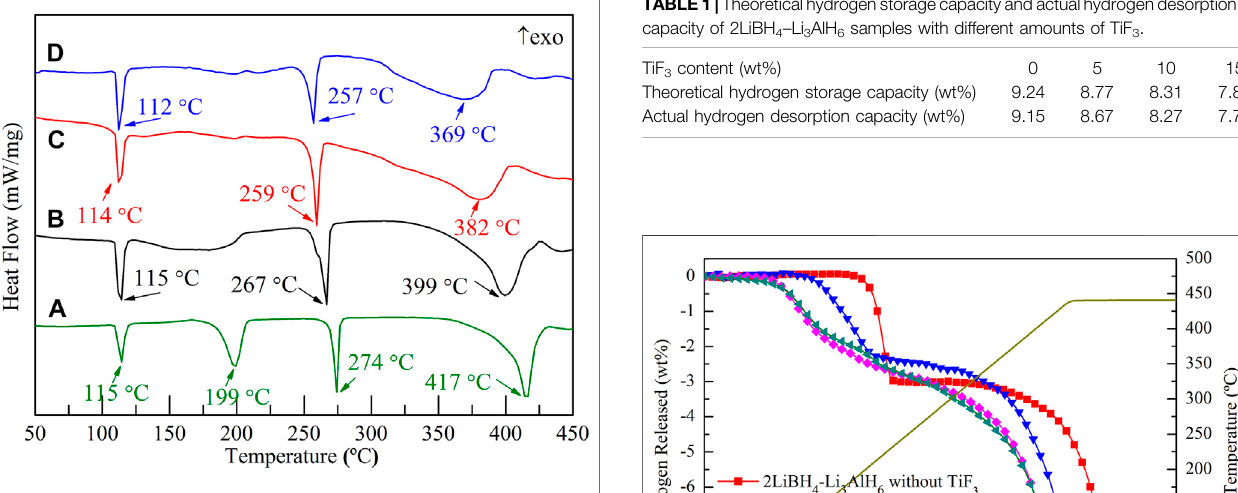
FIGURE 3 | DSC traces of 2LiBH 4 – Li 3 AlH 6 samples with different amounts of added TiF 3 : (A) 0 wt%, (B) 5 wt%, (C) 10 wt%, and (D) 15 wt%.